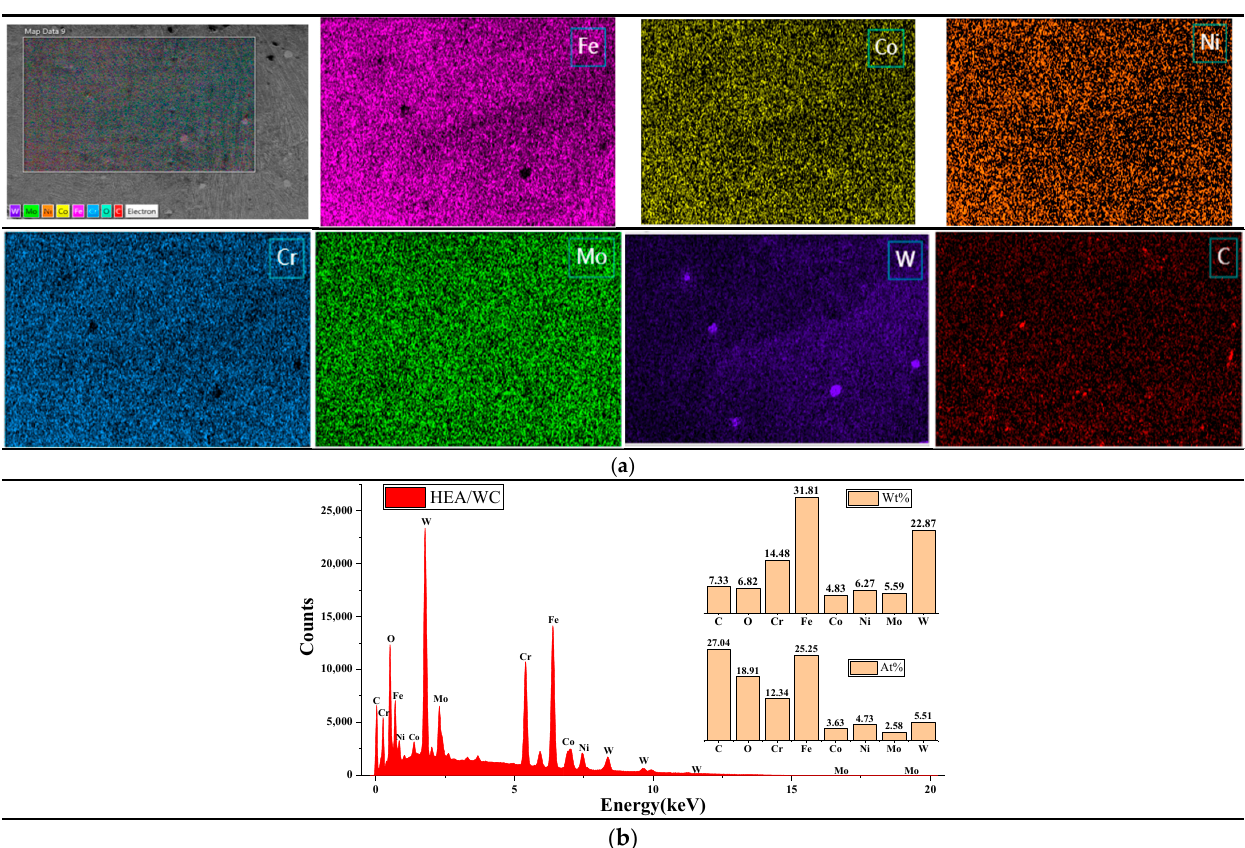
Figure 6. ( a ). The energy spectrum analysis results of each element of the HEA/WC coating. ( b ). The distribution of each element of the HEA/WC coating.